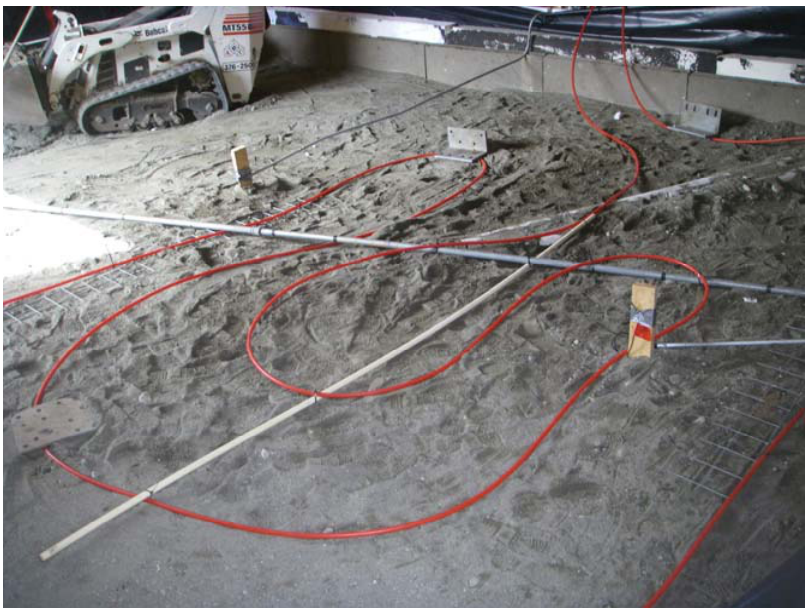
Figure 7. Cross ‐ linked polyethylene (PEX) heat loop installation in progress.